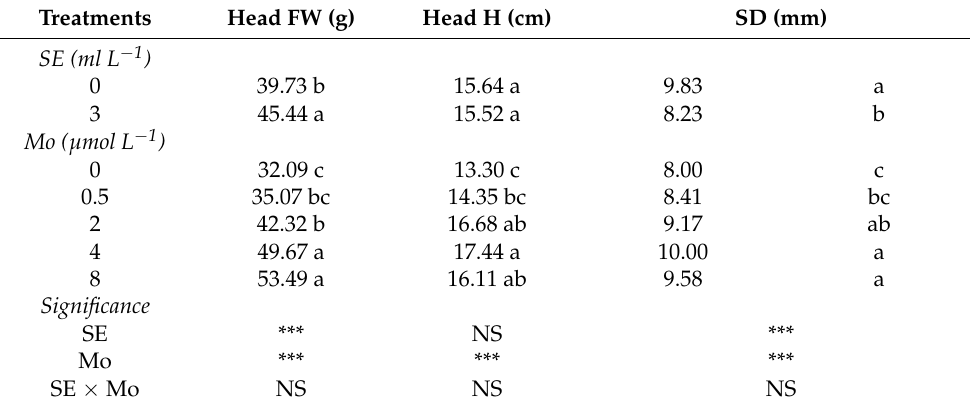
Table 1. Effect of SE application and Mo-biofortification on head fresh weight (head FW), head height (head H) and stem diameter (SD) of spinach plants cultivated in a protected environment.